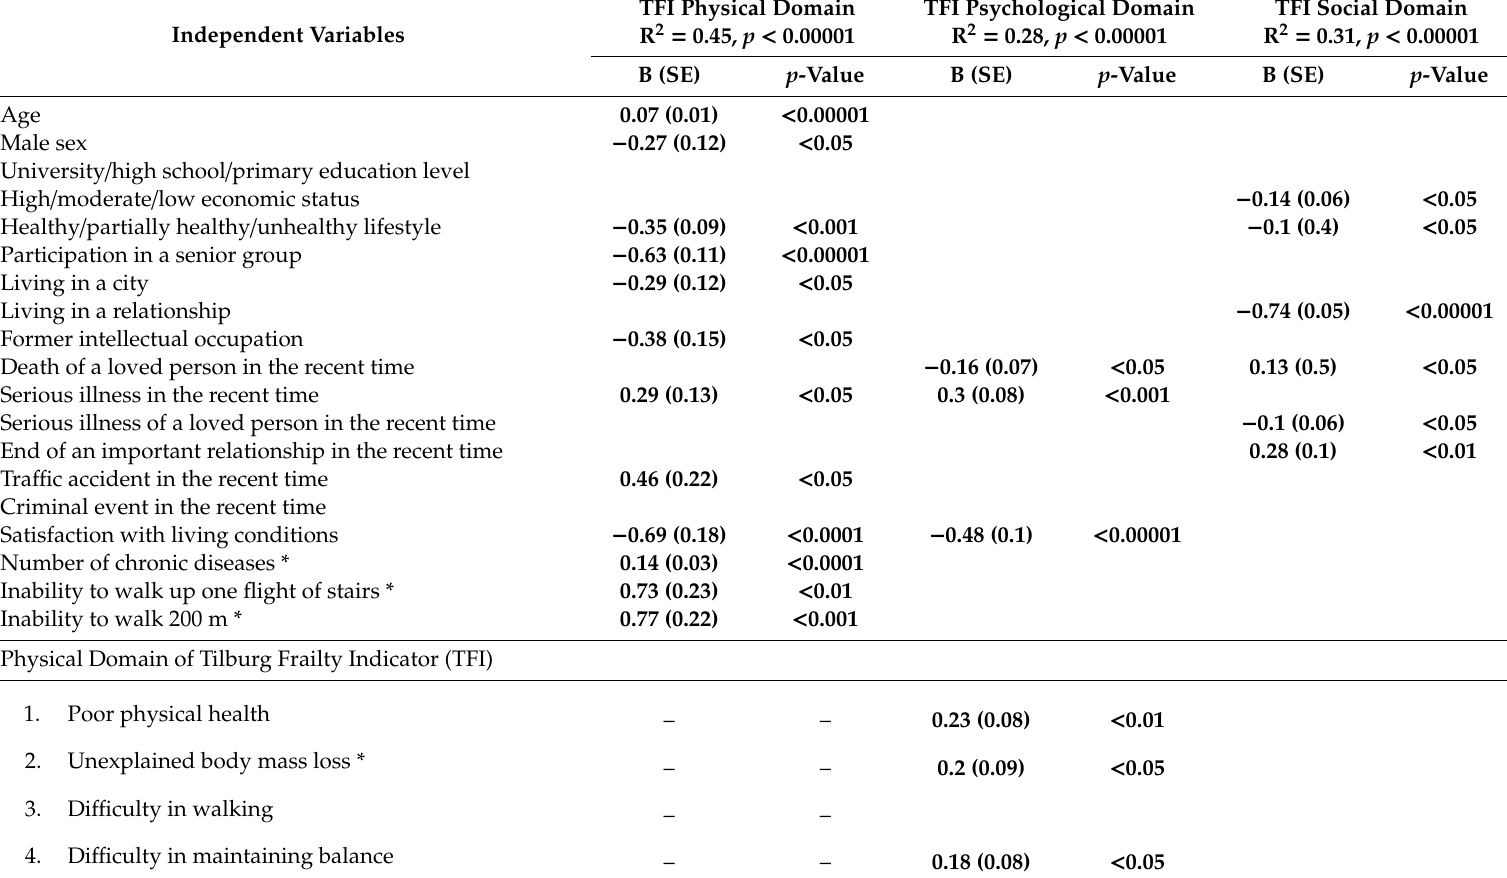
Table 5. Independent determinants for each TFI